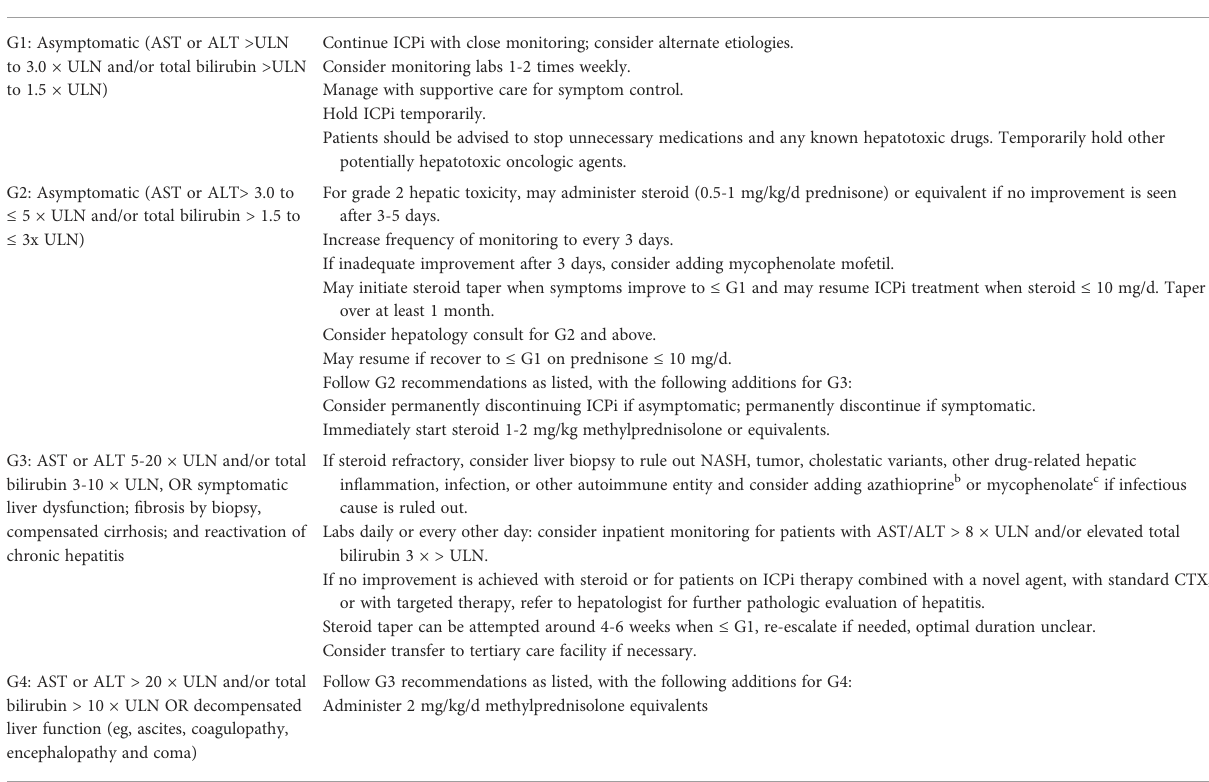
TABLE 1 Grading and management principles of immune-mediated liver injury induced by ICI. Grading